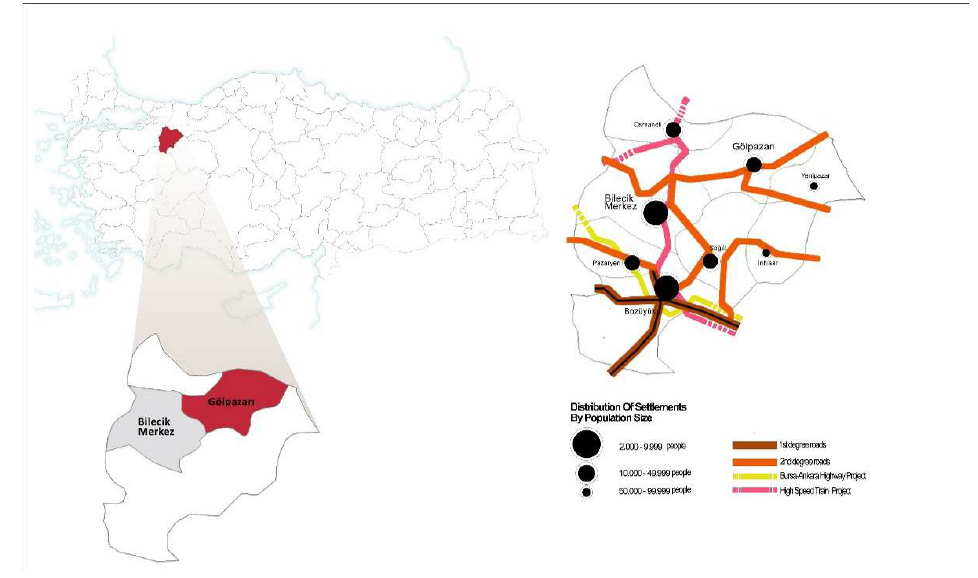
Figure 26 Bilecik and districts (illustrations arranged by Keep Your Village Alive